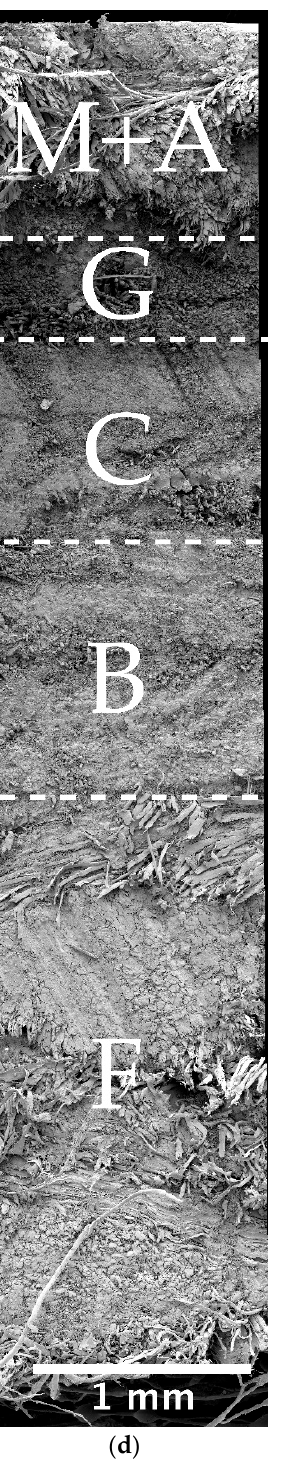
Figure 1. SEM images of cross-section of samples: GCABF ( a ), CGABF ( b ), CAGBF ( c ), MAGCBF ( d ), VGACBF ( e ), MGACBSF ( f ), magnification ×100.